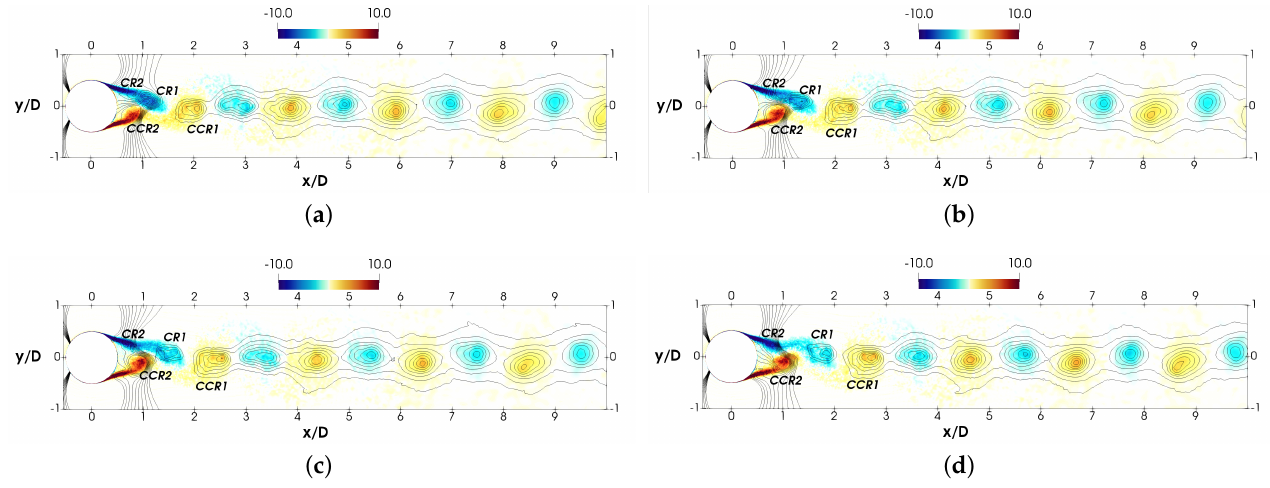
Figure 16. Phase averaged spanwise vorticity superimposed with pressure contours in the wake at constant phase. ( a ) φ = 0, ( b ) φ = π /4, ( c ) φ = π /2, ( d ) φ = 3 π